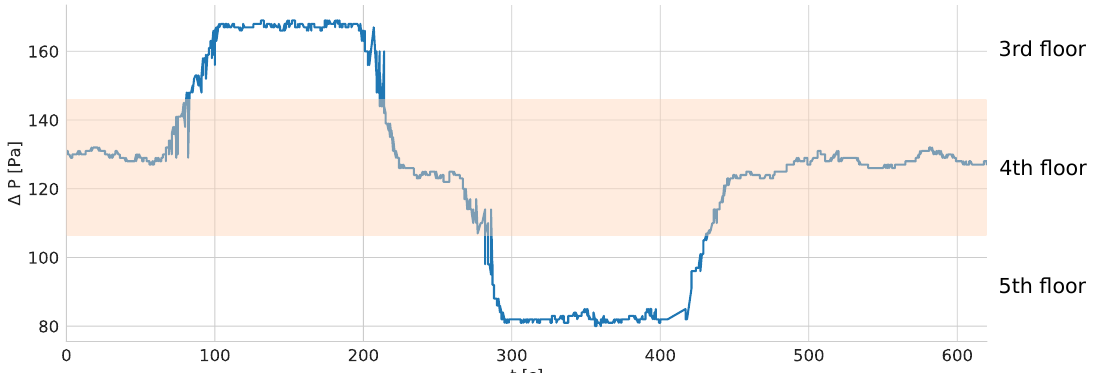
Figure 8. Difference between atmospheric pressure measured by the tag and the anchor, while moving one floor down and up.